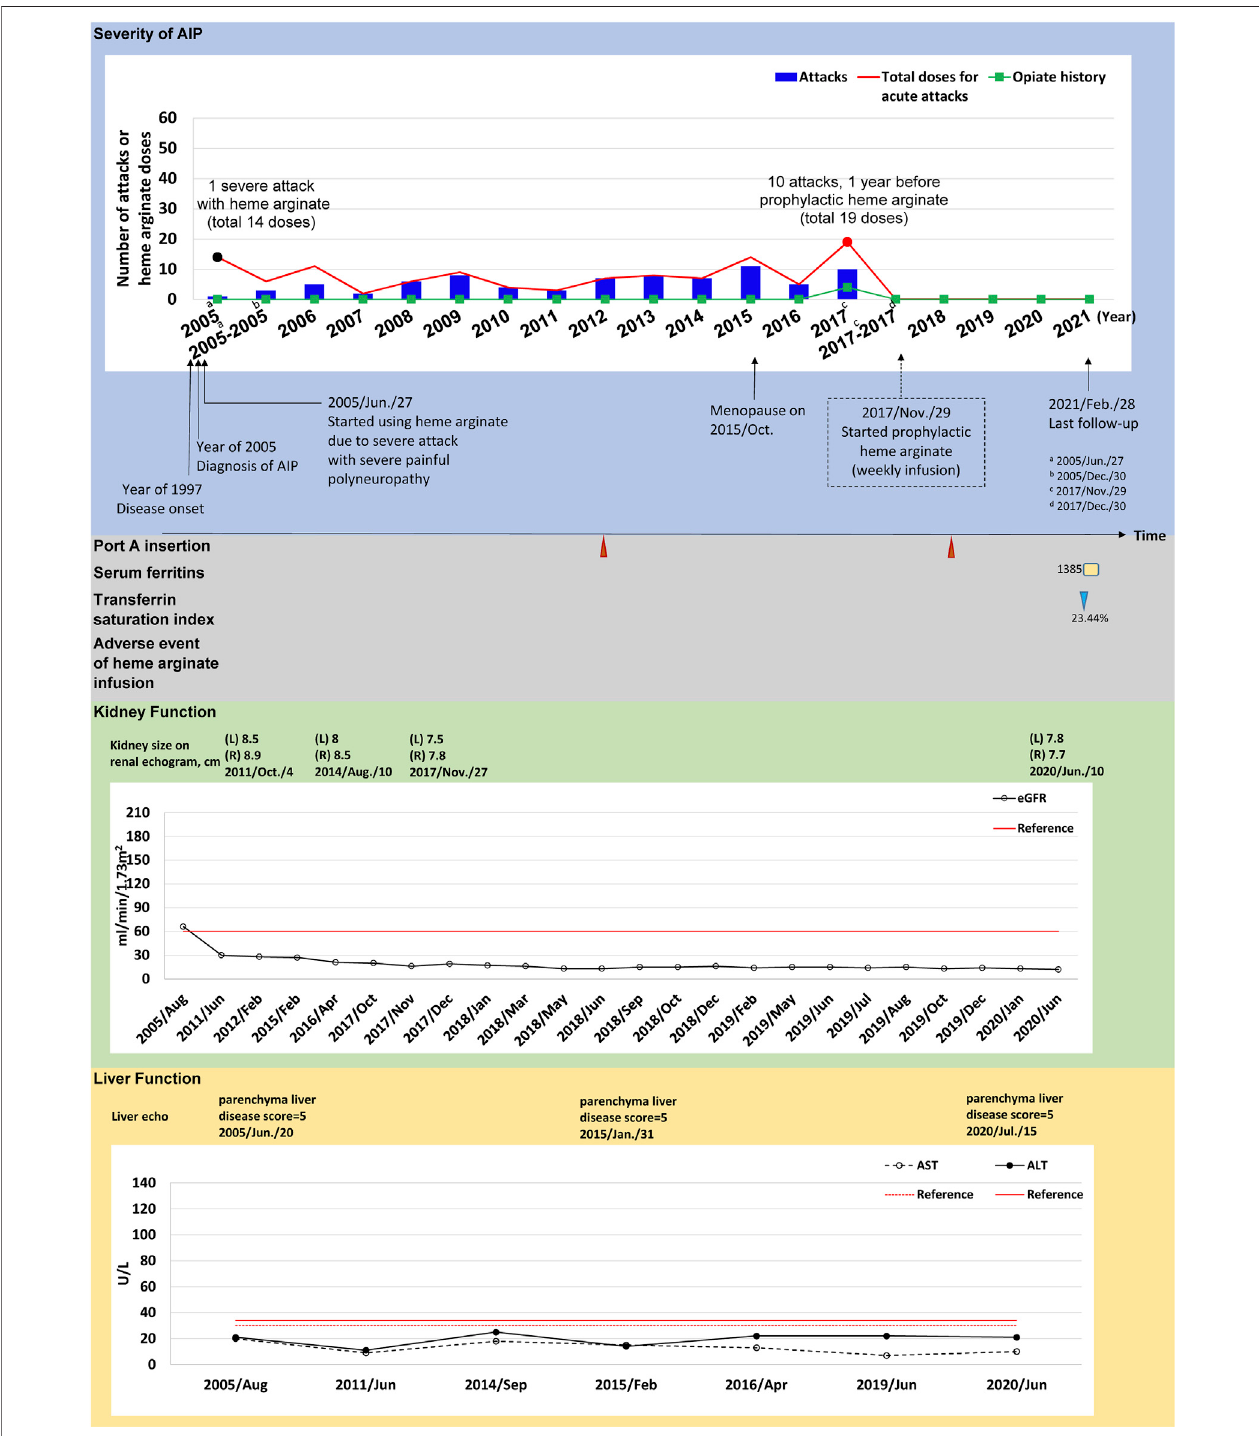
FIGURE2| ThetrackedinformationofAIPseverity,adverseevents,kidneyandliverfunctionforpatient#5.AIPseverityisidenti fi edbynumbersofattacksandtotal hemearginatedosesforporphyricattackstreated.Blackdotsindicatethemostsevereattack inthepast,whichwastreatedusinghemearginate.ReddotsindicateAIP severity status within 1-year before receiving prophylactic heme arginate. A dotted frame marks the initiation date of initial prophylactic heme arginate infusion. Port A insertionandadverseeventsofhemearginateinfusionareshownasredtrianglewithgivenexamineddate,PortA-relatedinfectionisshownasagreenoval.Serum ferritin is indicated as yellow square. Transferrin saturation index (% of serum iron relative to TIBC) is shown as blue triangle. Kidney function is recorded as eGFR level, andsizesofleft(L)andright(R)sideofkidneyalongwithexamineddate.LiverfunctionisrecordedasALTandASTlevels,andparenchymalliverdiseasescorealongwith examined